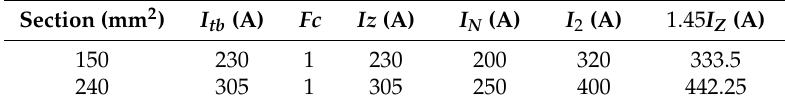
Table 5. Overload conditions. Results of Equation (4).